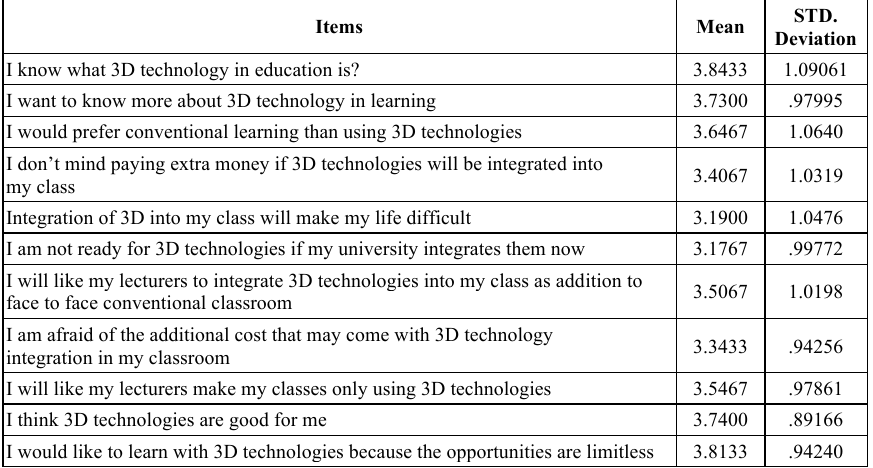
Table 3. Showing Means and Standard deviation of students' response to 3D questionnaire Items Mean